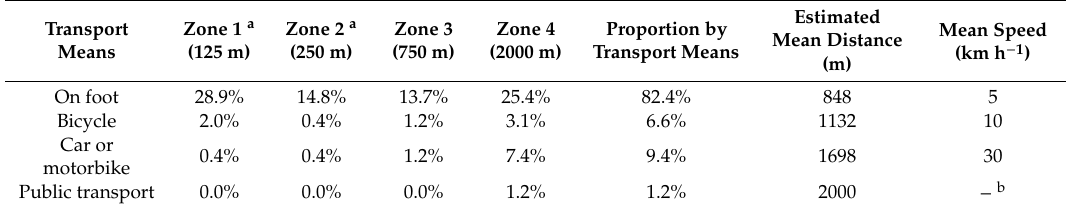
Table 1. Proportion of visitor’s residence distance and transport means in the greenspaces of